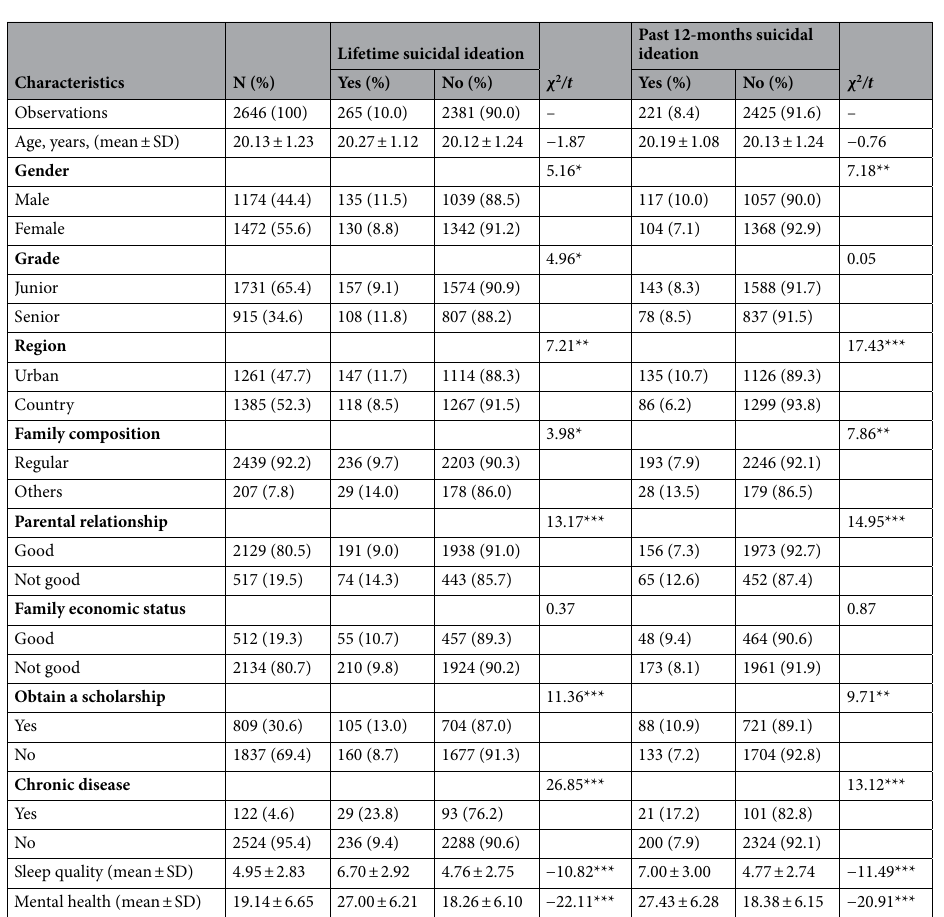
Table 1. Description and univariate analysis of suicidal ideation among the medical college student in Shandong, China (N = 2646). Others family composition include restructured families (67, 2.53%), single- parent families (119, 4.50%) and others (21, 0.79%). *p<0.05; **p<0.01;